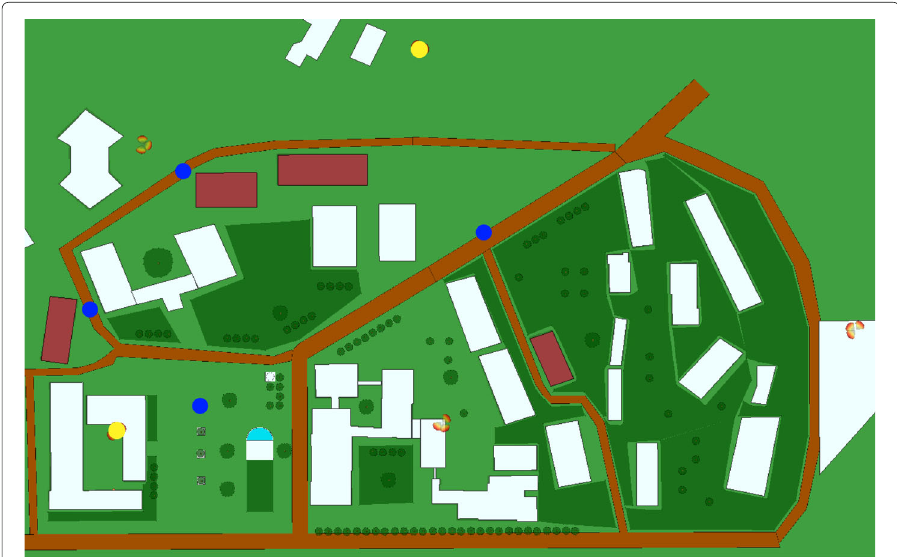
Fig. 15 Map model built by the Wireless